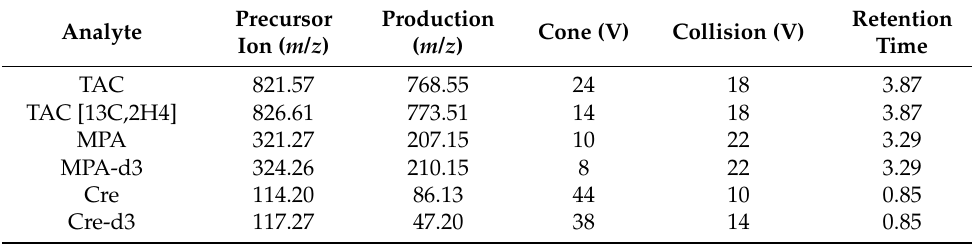
Table 1. Mass spectrometer settings for